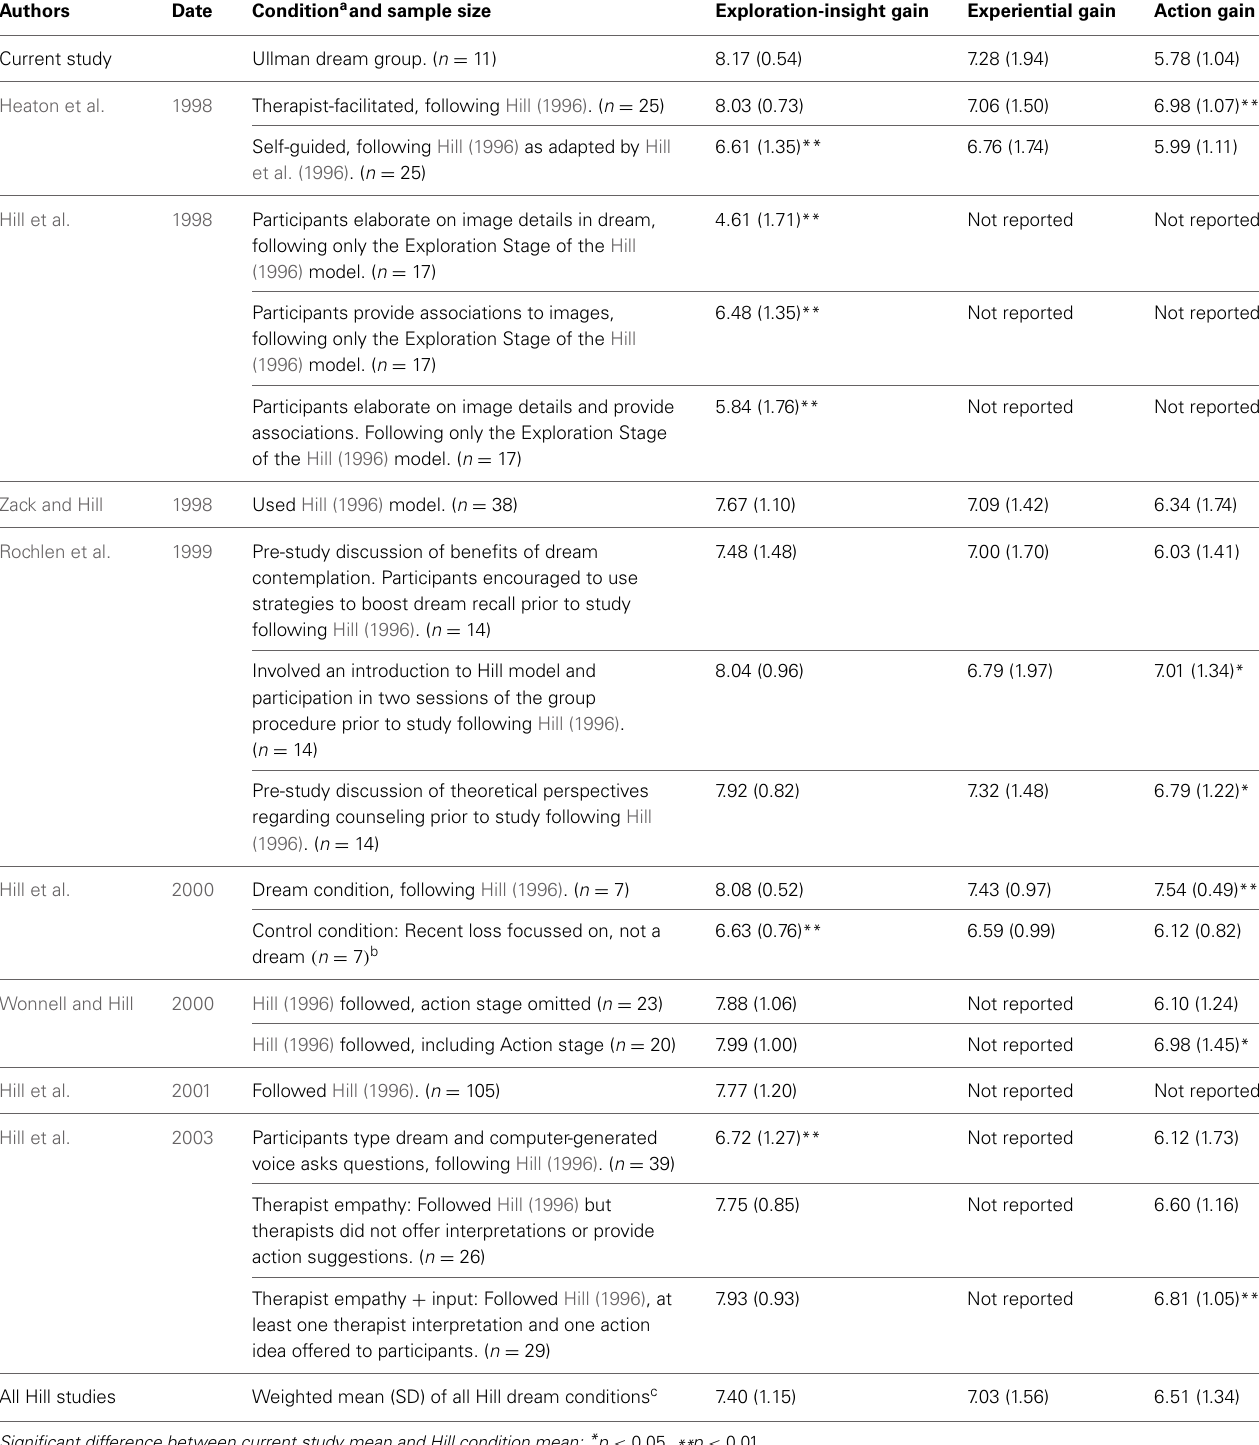
Table 2 | Gains from Dream Interpretation subscale means (and SDs) from papers by Hill, with comparison of current study with Hill studies’ subscale means, and comparison of current study means with weighted subscale means of all Hill dream conditions.